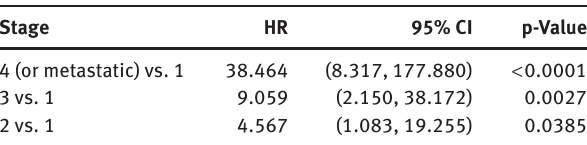
Table 4: Prognostic significance of the stage in multivariate analysis.